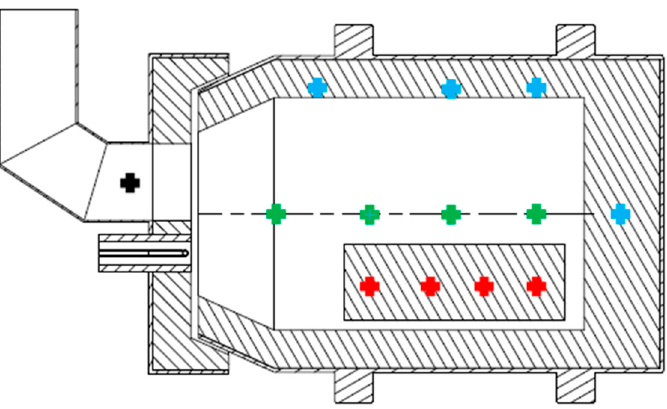
Figure 1. Experimental model of tilting rotary furnace.